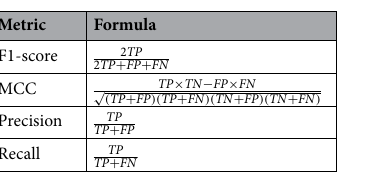
Table 1. Derivation of performance evaluation metrics from confusion matrix